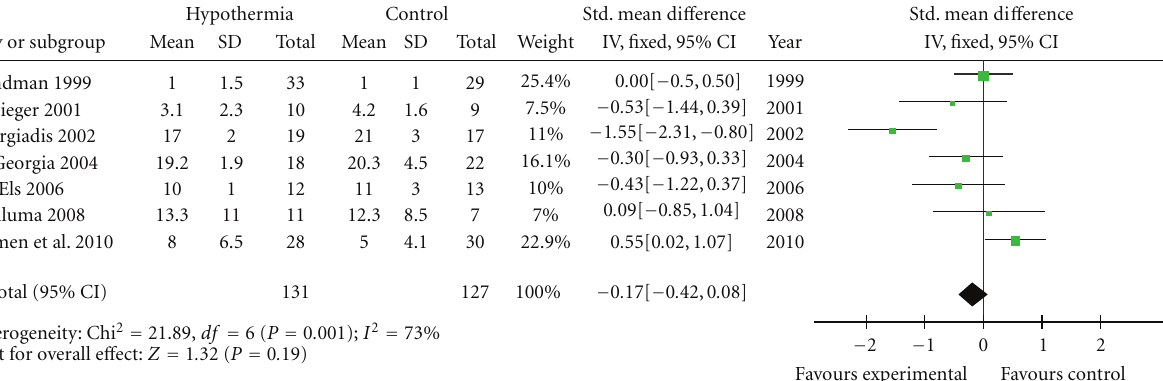
Figure 2: Forest plot illustrating the meta-analysis of the clinical outcome (stroke severity) presented in the controlled clinical trials of hypothermia and stroke.